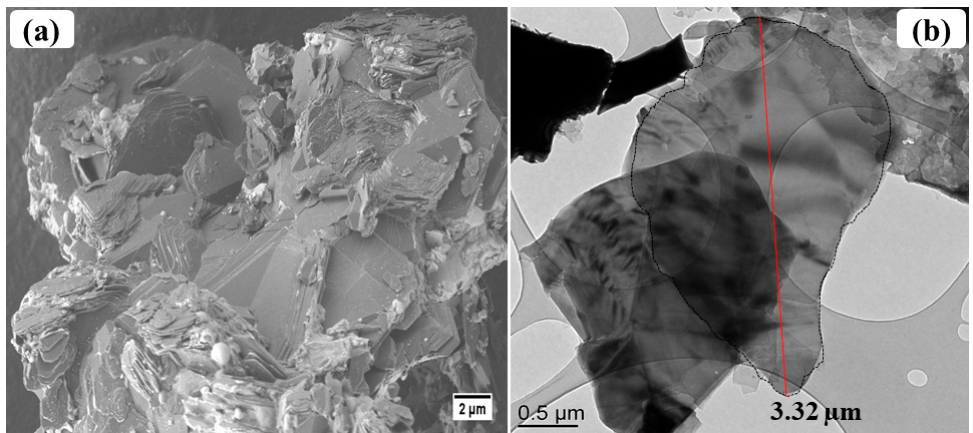
Figure 5. ( a ) SEM and ( b ) TEM micrographs of as-synthesized BNNS materials annealed at 1200 °C after the addition of 5 wt.% BaF 2 .